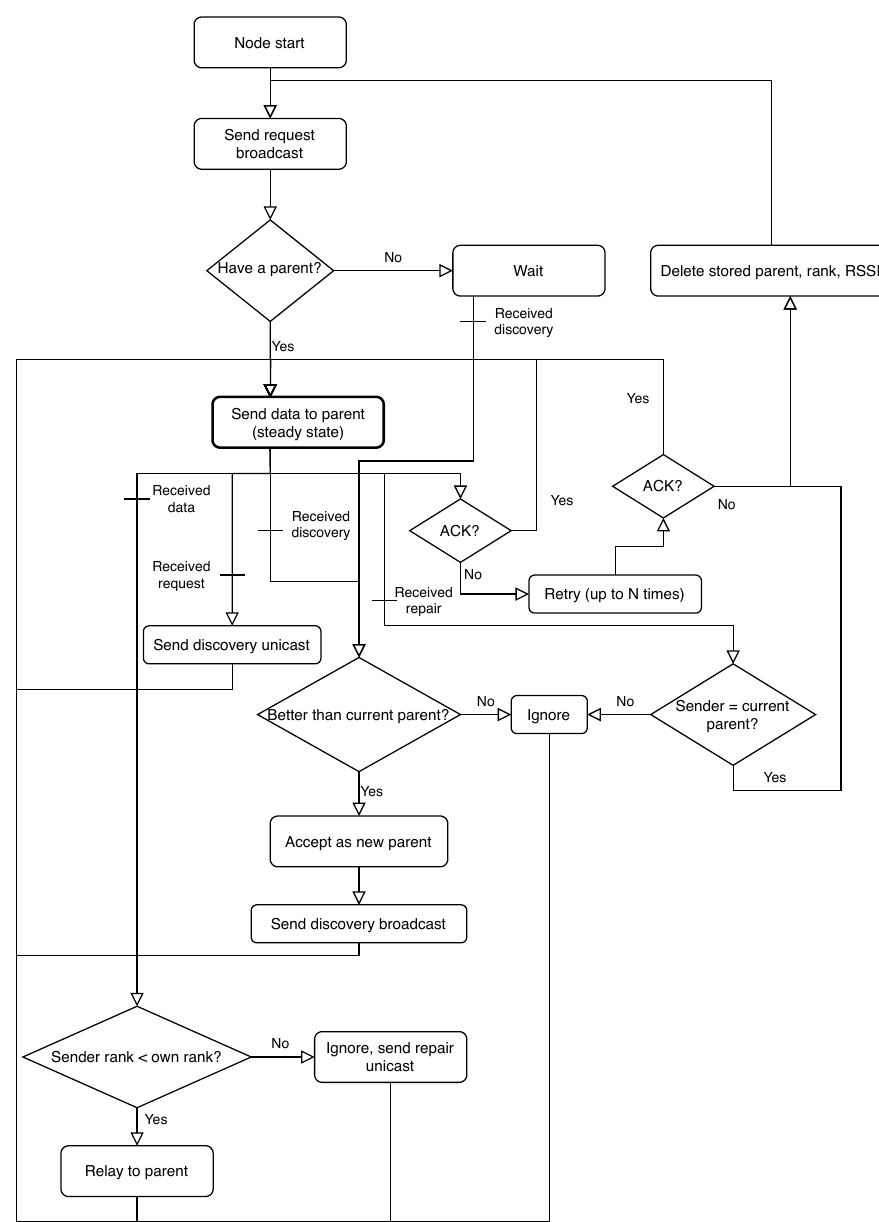
Figure 8. State machine of a sending node (non-root) under